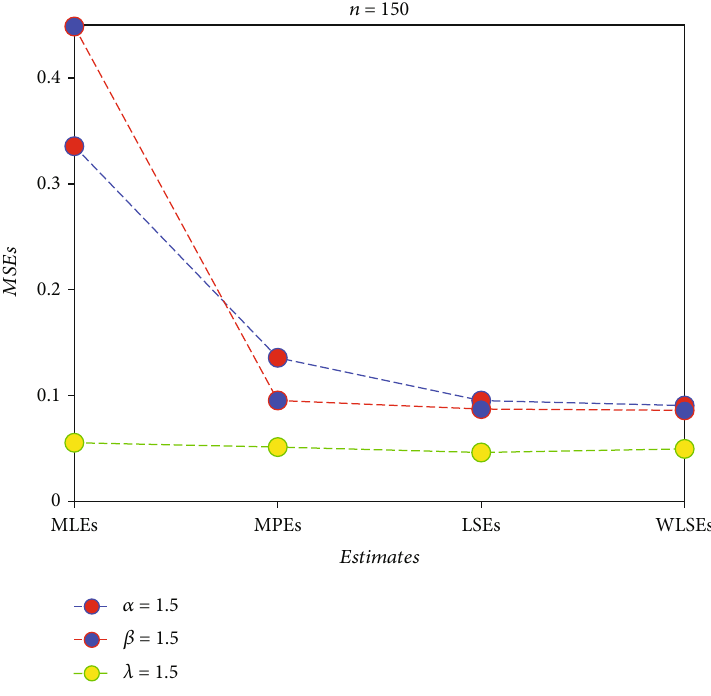
Figure 12: MSEs using n = 150 : α = 1 : 5 , β = 1 : 5 , and λ = 1 : 5 . Table 6: The lifetime number of days, in increasing order, for 65 patients su ff ering from breast